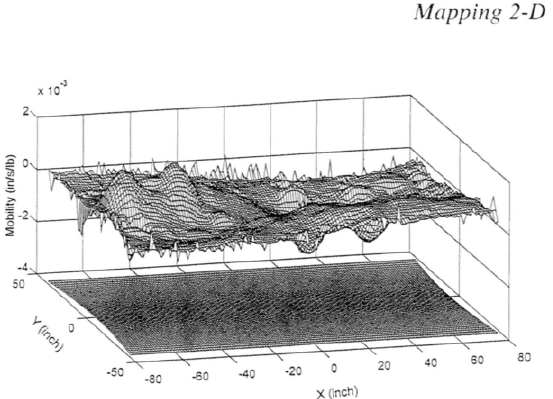
FIGURE 5 The original unevenly spaced SLDV data (66 x 153, real part) from the left side of the fuselage at 150 Hz.